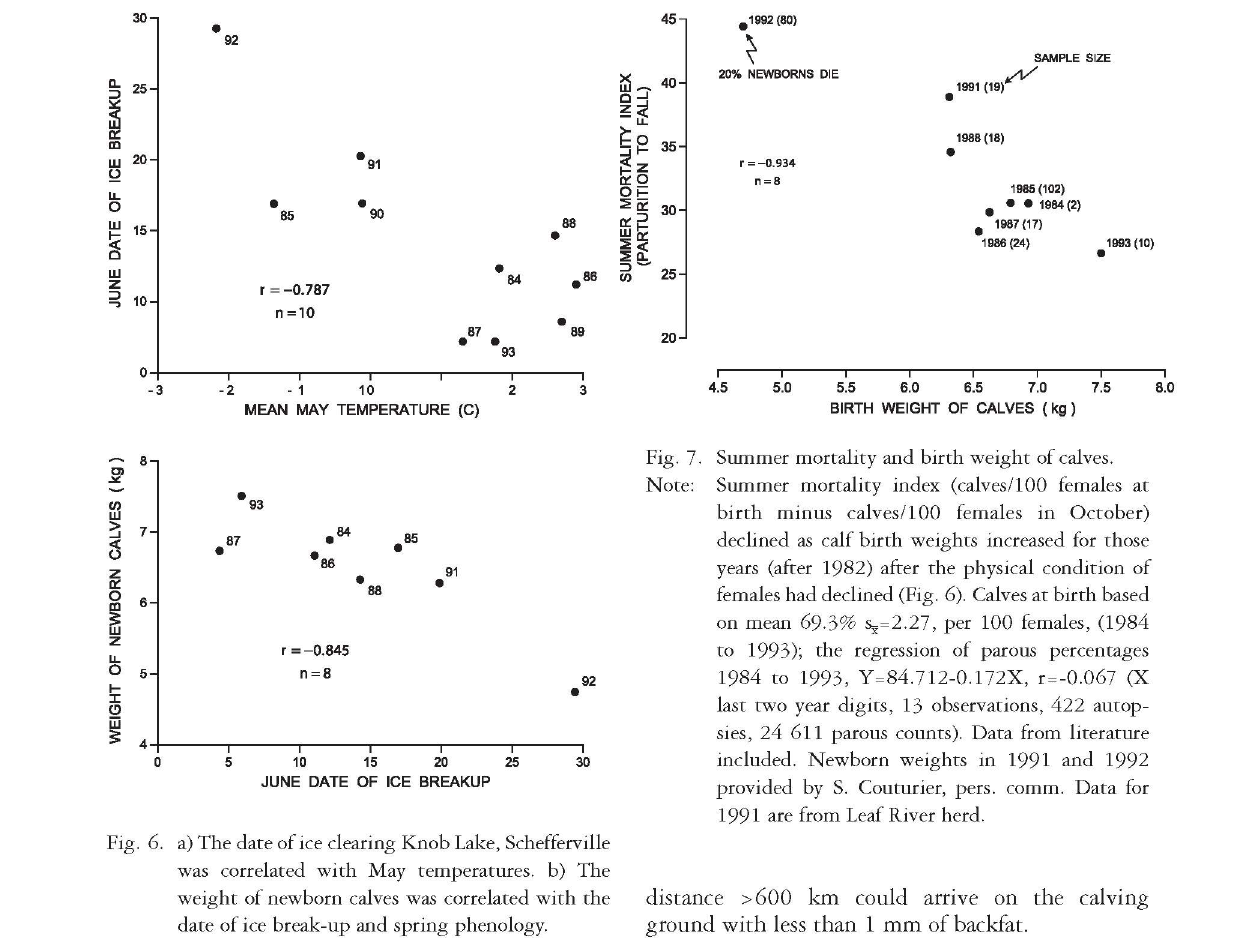
Fig. 7. Summer mortality and birth weight of